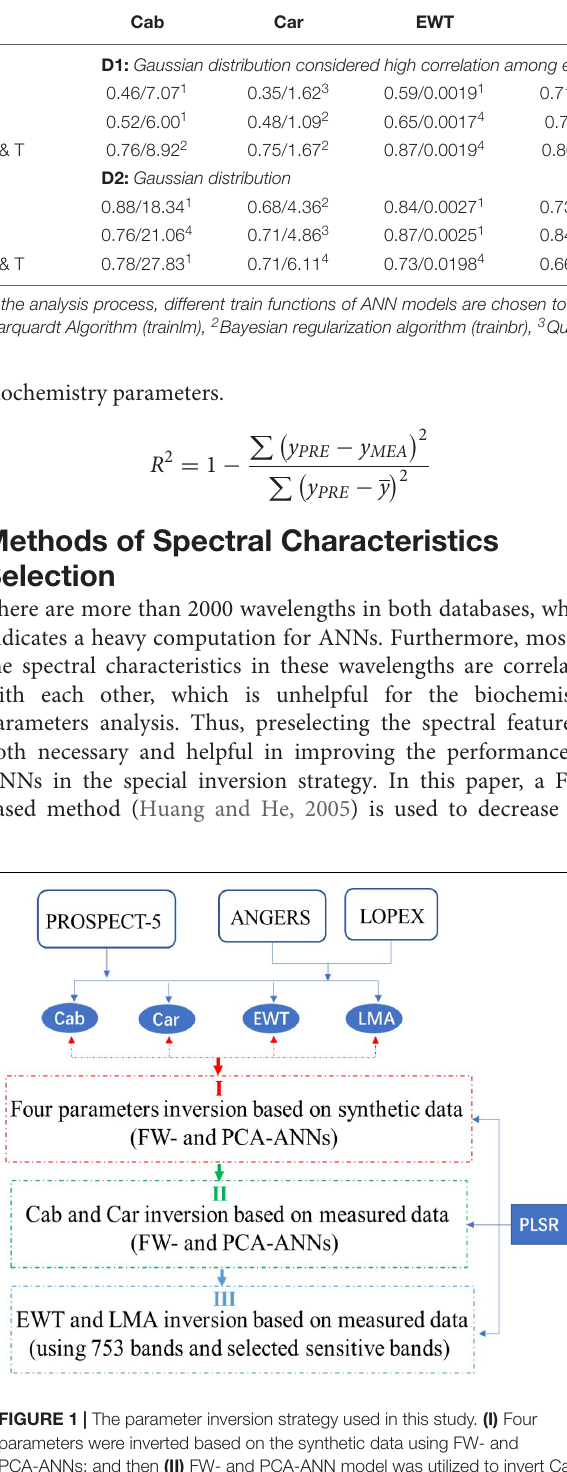
TABLE 2 | The R 2 /RMSE of FW- and PCA-ANNs models for analyzing four parameters together based on two synthetic databases. Spectra Car Cab Car EWT